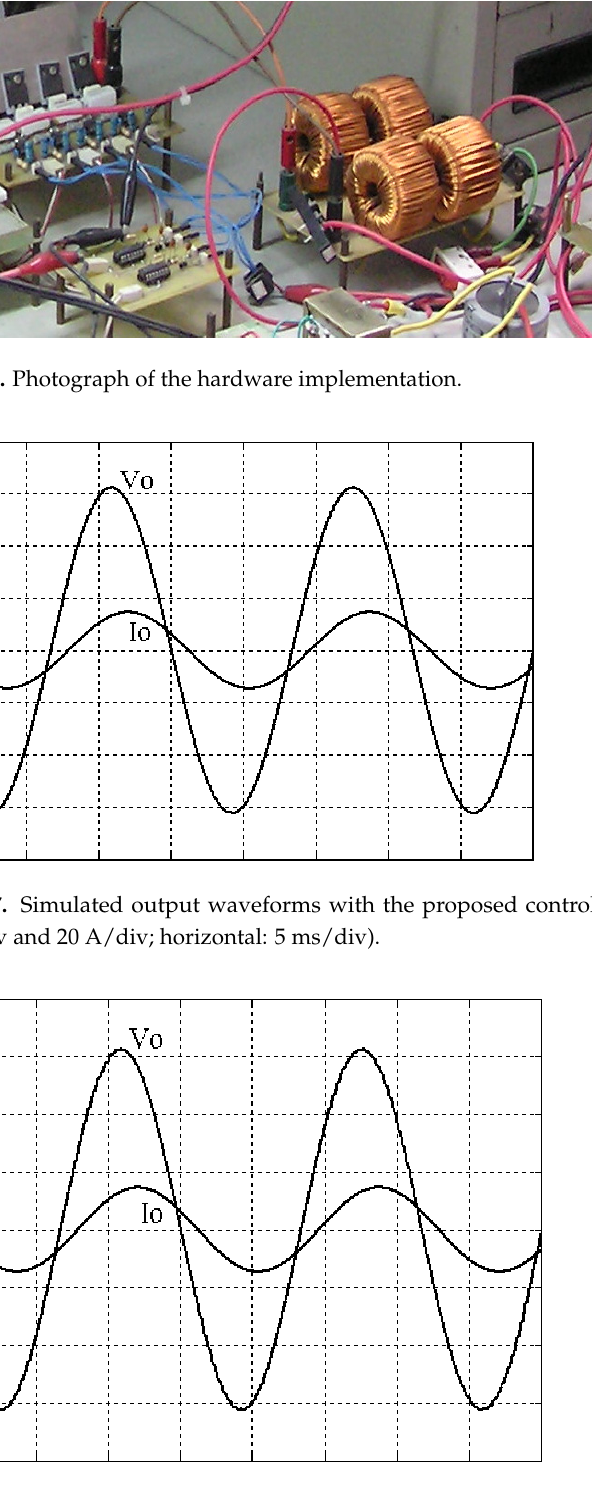
Figure 5. Block diagram of the experimentation.